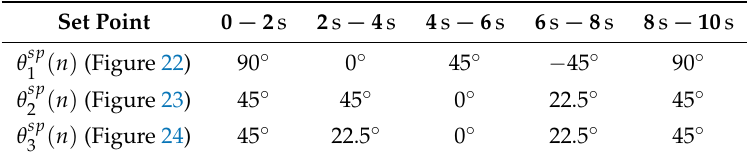
( n ) , θ sp ( n ) and θ sp ( n ) . 2 3 1